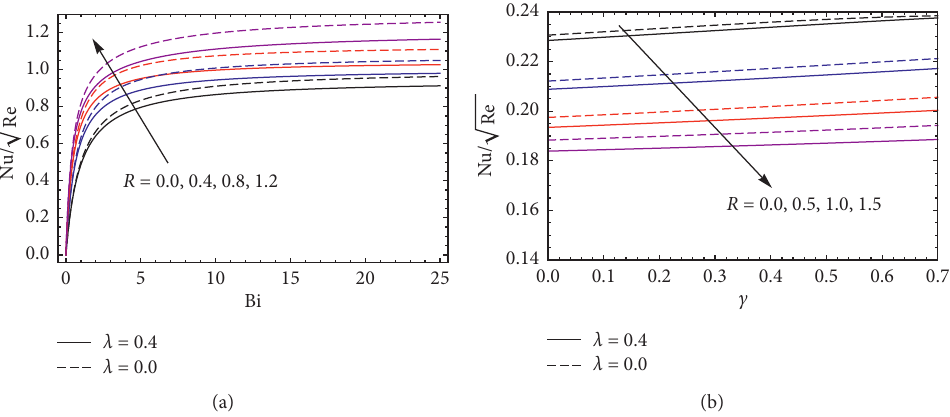
Figure 7: Impact of the Nusselt number on combined parameters. (a) R and Bi and (b) R and c .